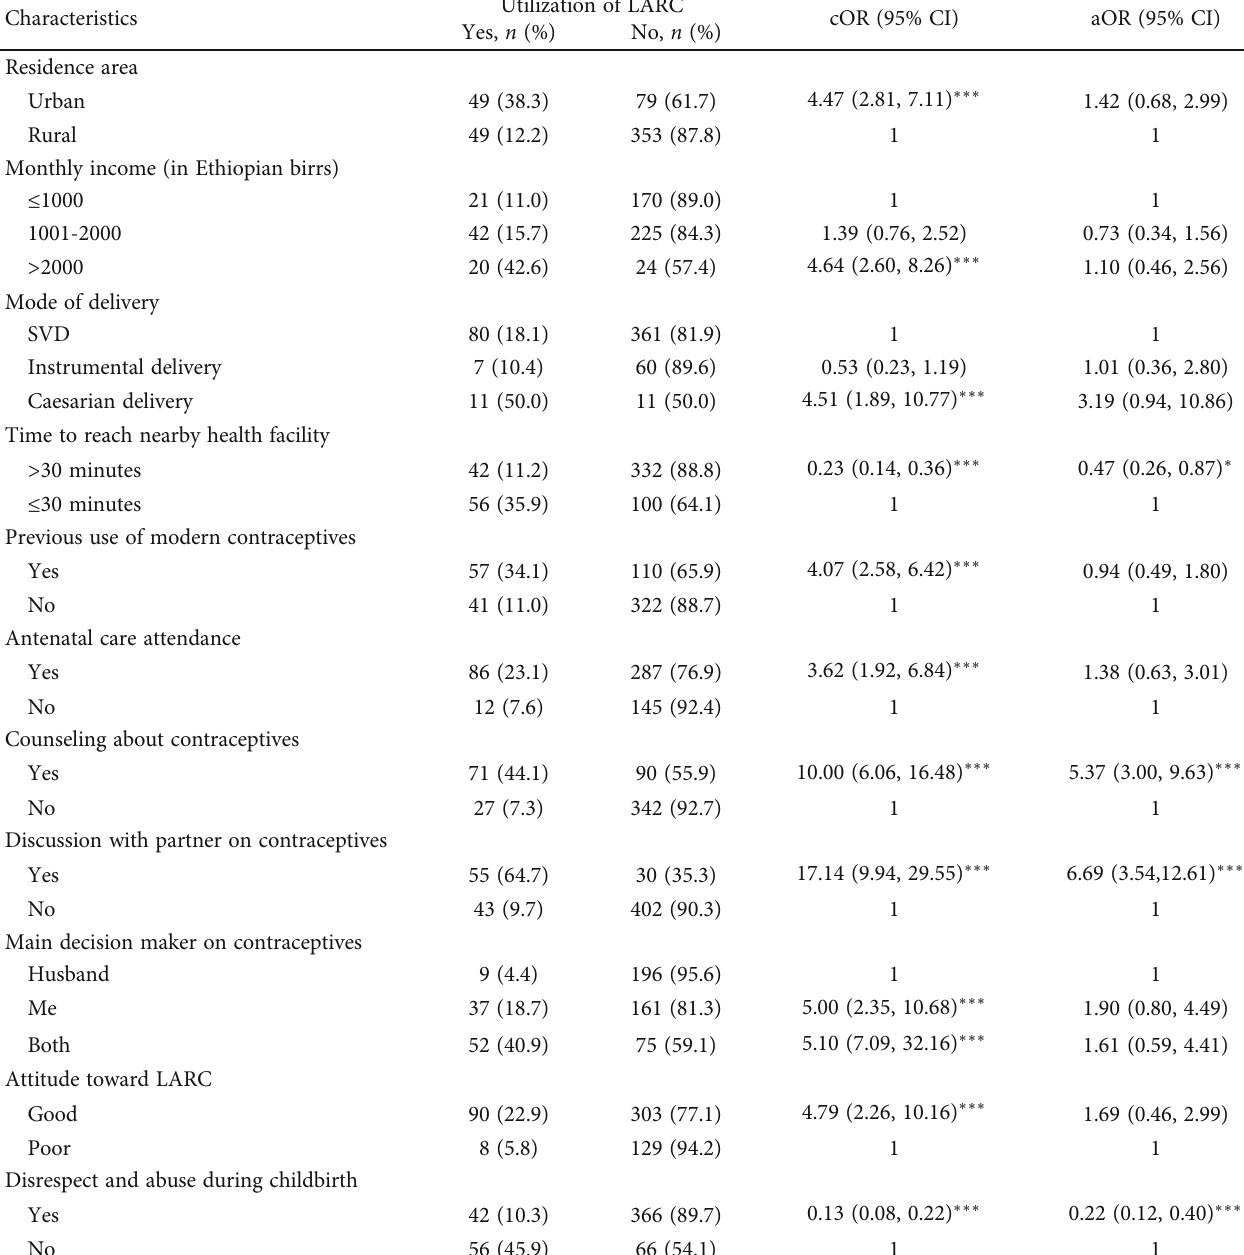
Table 3: Factors associated with utilization of immediate postpartum LARC among women giving birth in public health facilities in East Hararghe Zone, eastern Ethiopia, 2020 ( n = 530